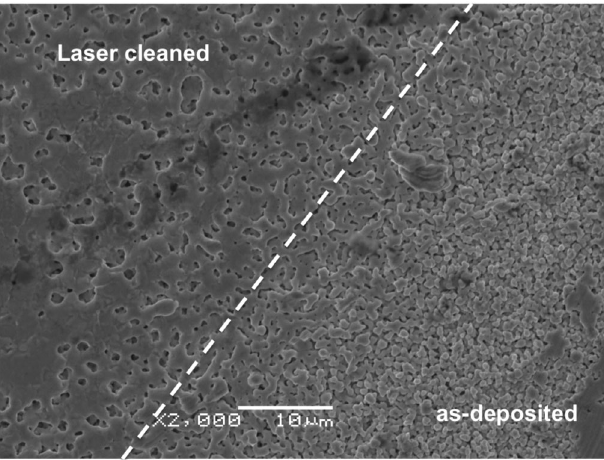
FIG. 8. SEM micrograph of the as-deposited Pb film, deposited on Nb at 0 : 12 J = cm 2 with pulse duration of 5 ps, before and after laser